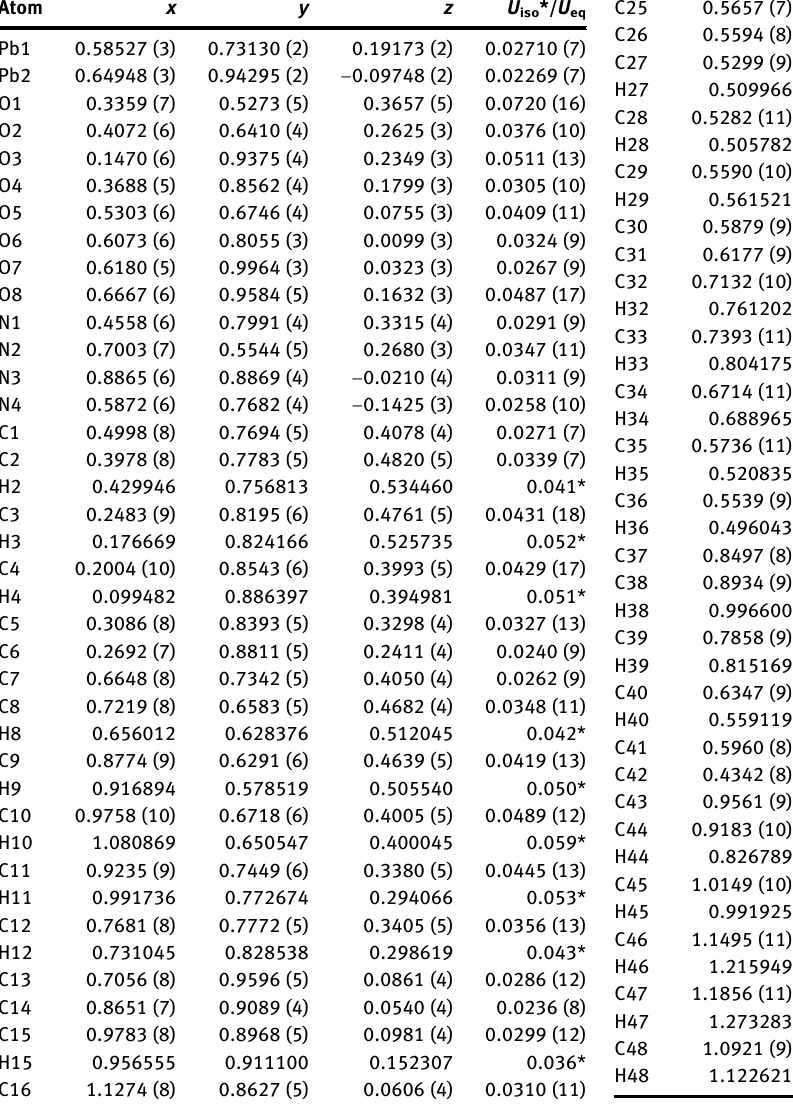
Table  : Fractional atomic coordinates and isotropic or equivalent isotropic displacement parameters (Å  ).